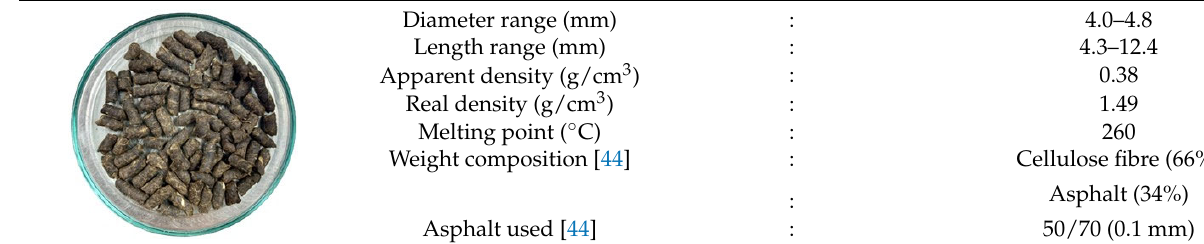
Figure 3. Temperature TGA profile of the WTTF ‐ based additive used in this study. 2.2. Cellulose Commercial Additive SMA mixes have a high content of asphalt binder; additives must, therefore, be used to stabilise the mix, preventing asphalt draindown. In this study, the reference mix contained a cellulose commercial additive, the main characteristics of which are shown in Table 2. Table 2. Characterization of the cellulose commercial additive. Table 2. Characterization of the cellulose commercial